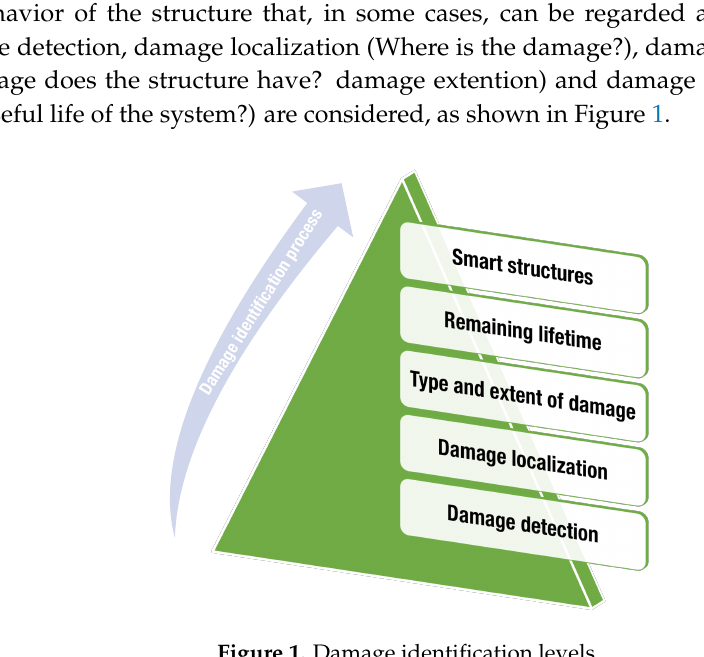
Figure 1. Damage identification